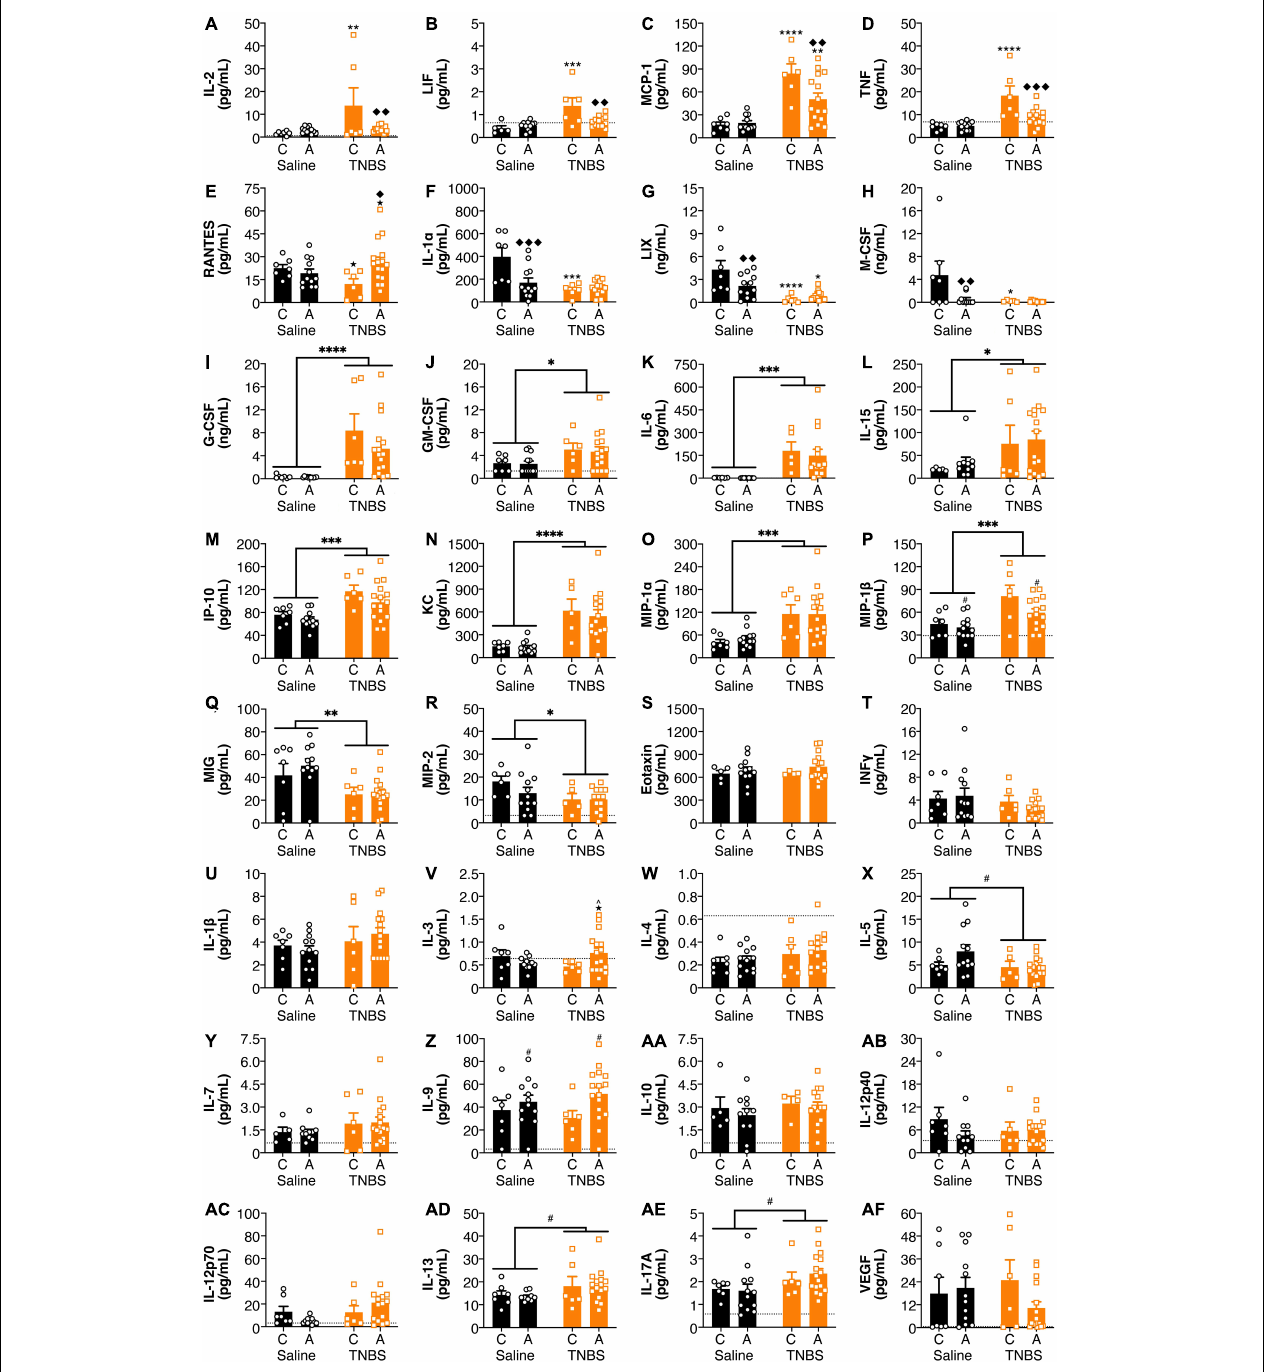
FIGURE 2 | FAAH SNP altered colitis-induced changes in plasma cytokines and chemokines. Having an A allele mitigated colitis-induced increases in (A) IL-2, (B) LIF, (C) MCP-1, and (D) TNF and reductions in (E) RANTES. Both possessing an A allele or colitis reduced levels of (F) IL-1 α , (G) LIX, and (H) M-CSF, but there was not an additive effect of both conditions. Colitis increased levels of (I) G-CSF, (J) GM-CSF, (K) IL-6, (L) IL-15, (M) IP-10, (N) KC, (O) MIP-1 α and (P) MIP-1 β and reduced levels of (Q) MIG and (R) MIP-2. There were no significant changes in (S) Eotaxin, (T) IFN γ , (U) IL-1 β , (V) IL-3, (W) IL-4, (X) IL-5, (Y) IL-7, (Z) IL-9, (AA) IL-10, (AB) IL-12p40, (AC) IL-12p70, (AD) IL-13, (AE) IL-17A, and (AF) VEGF. n = 4–16/group. (cid:70) p < 0.1, * p < 0.05, ** p < 0.01, *** p < 0.001, **** p < 0.0001, saline vs. TNBS of same genotype. ˆ p < 0.1, (cid:7) p < 0.05, (cid:7)(cid:7) p < 0.01, (cid:7)(cid:7)(cid:7) p < 0.001, C vs. A of same condition (saline or TNBS). # p < 0.1, ∗ p < 0.05, ∗∗ p < 0.01, ∗∗∗ p < 0.001, ∗∗∗∗ p < 0.0001 main effect of colitis (lines) or genxotype (symbols above bars). Saline = left pair, black bars with circles. TNBS = right pair, orange bars with squares. In each pair, the left bar is the C allele group (CC genotype) and the right bar is the A allele group (AC/AA genotypes). Dotted lines indicate minimal detection threshold for the analyte and was included in graphs where values were below threshold or the threshold value was used.